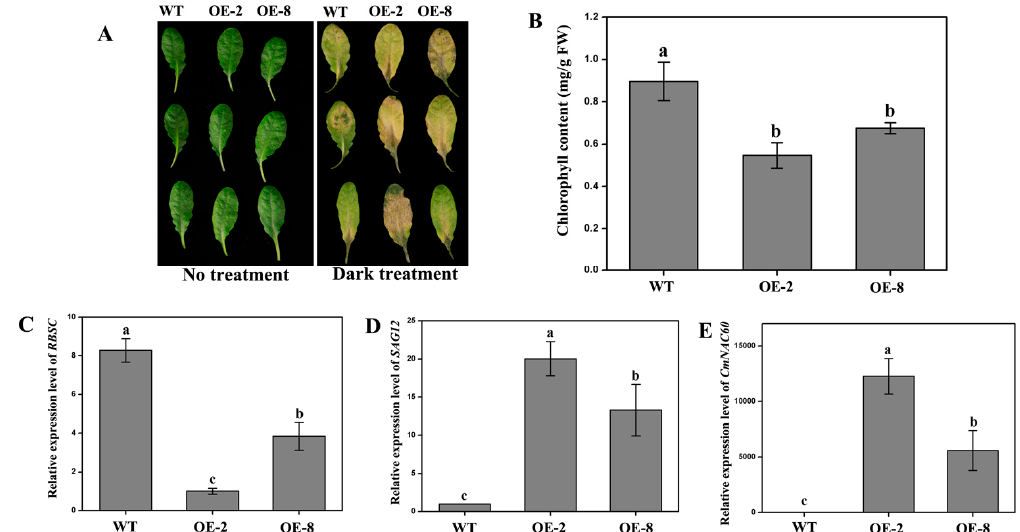
11 of 17 Figure 6. Tissue specific expression of CmNAC60 in transgenic Arabidopsis . ( A ) Seven-day-old seedlings. ( B ) Root, ( C ) inflorescence, ( D ) immature silique, and ( E ) stem of a six-week-old plant. ( F , H ) Non-senescing and senescing rosette leaves of a six-week-old plant before GUS staining. ( G , I ) Rosette leaves after GUS staining corresponding to ( F,H ). 3.7. Overexpression of CmNAC60 in Arabidopsis Accelerates Leaf Senescence To study the function of CmNAC60 in the leaf senescence, the transgenic Arabidopsis plants overexpressing CmNAC60 driven by the CaMV 35S promoter were generated. Ten T 3 homozygous transgenic lines were obtained by selection on a medium containing kanamycin, followed by PCR confirmation. Then, two independent homozygous transgenic lines (OE-2 and OE-8 lines) were selected randomly for further study. After the detached leaves of Arabidopsis were dark-treated for five days, the leaves of the two transgenic lines turned yellow faster than that of the wild type (WT; Figure 7A). In addition, the chlorophyll contents in the leaves of the two transgenic lines decreased significantly compared with the WT (Figure 7B). The relative expression levels of SAG12 in the leaves of the two transgenic lines increased significantly compared with WT, while RBSC decreased markedly (Figure 7C,D).